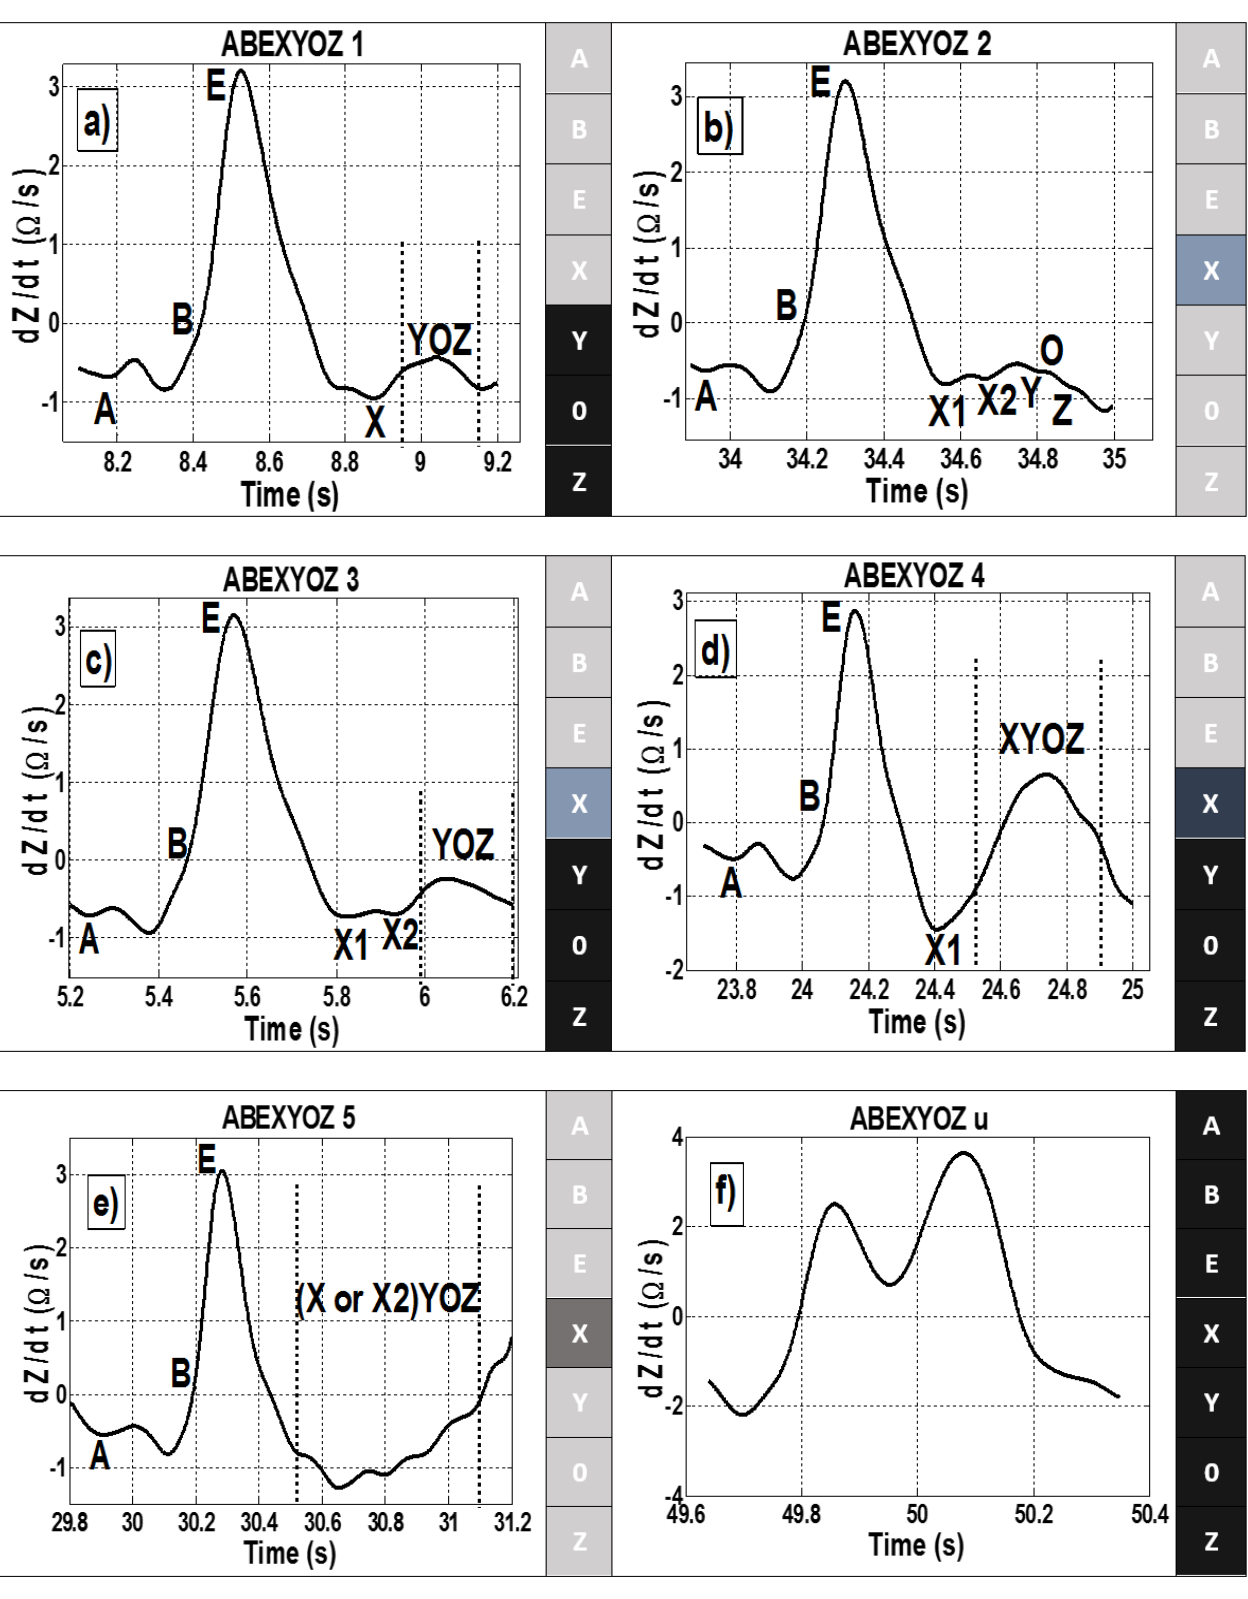
Fig. 4: Observed waveform morphology changes (ABEXYOZ types) of the dZ/dt signal. Refer to X2 Refer to the presence of the notches of the characteristic point Refer to X1 Refers to unclear or absent notches of the characteristic point Refer to X or